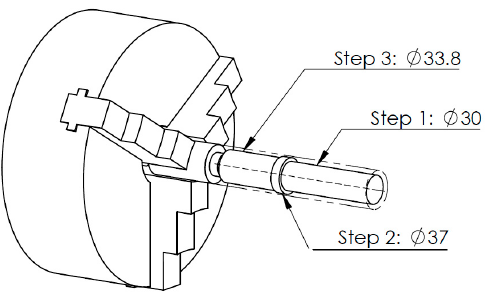
Figure 15. Orientation of the parts to be machined in relation to the prefabricated item.